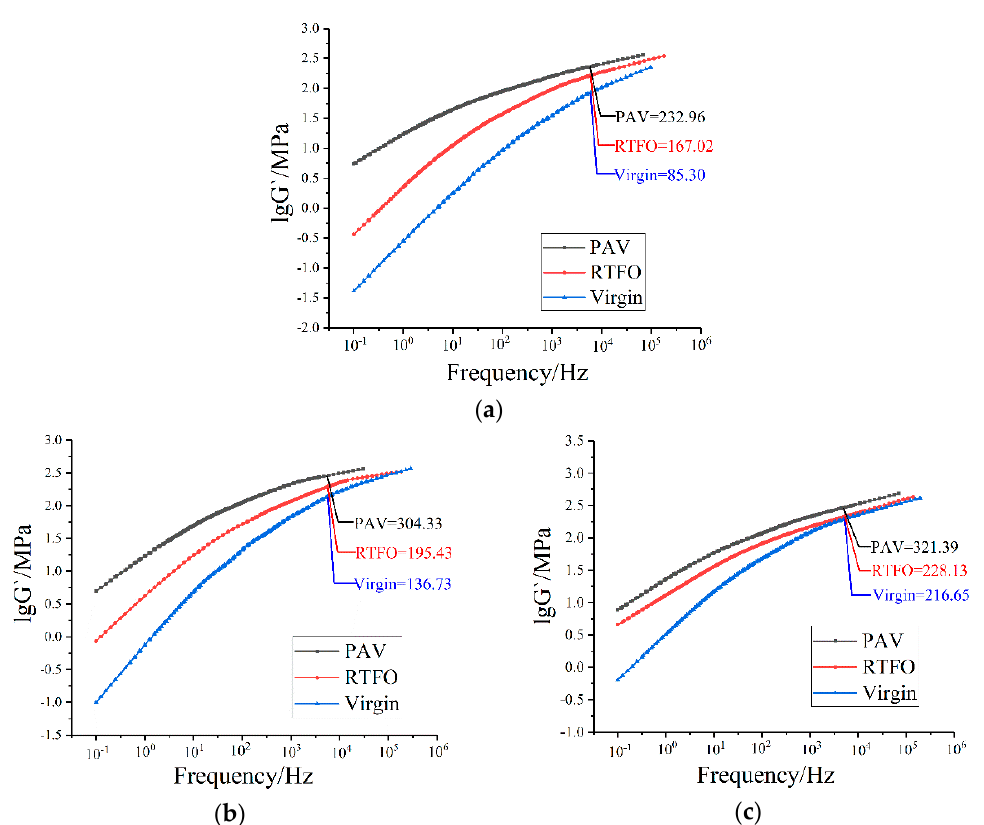
Figure 9. Master curves of bitumen storage modulus G ′ at 20 °C: ( a ) 70# bitumen; ( b ) 50# bitumen; ( c ) 30# bitumen.